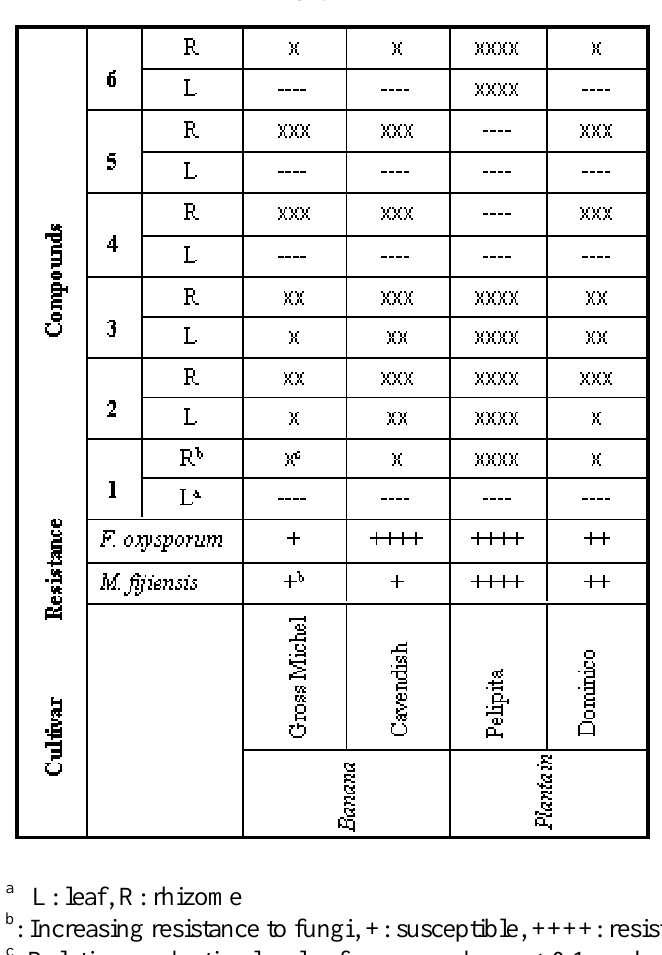
Table 1. Relative concentrations of phenylphenalenones in some Musa varieties and resistance against Mycosphaerella fidjiensis and Fusarium oxysporum var. cubensis race